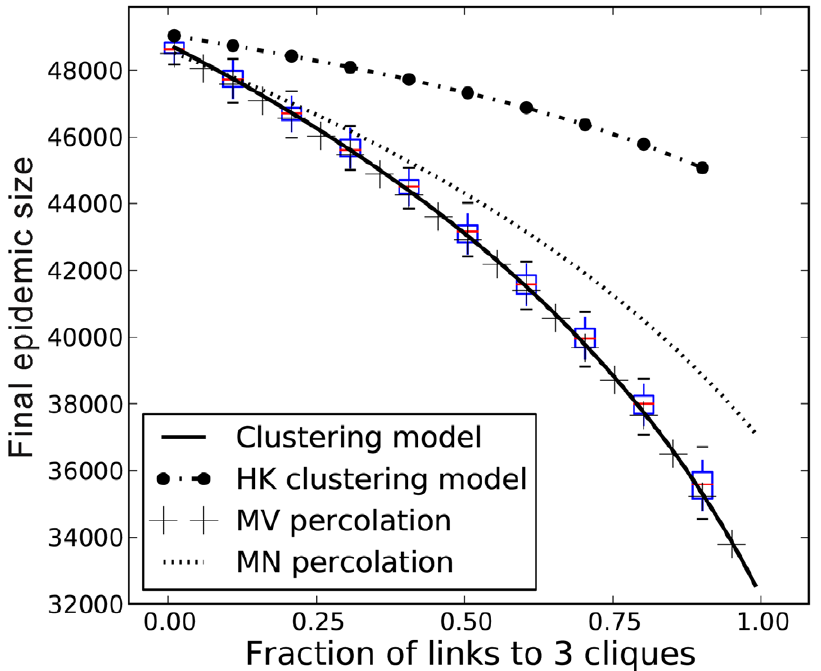
Figure 3. Comparison of clustering models. The degree distribution is Poisson for the number of pairs of edges (mean degree ~ 2 ). The black line corresponds to the solution of equations 13–17. The boxplots illustrate the 90% confidence interval from 50 stochastic simulations on networks with 5000 nodes. The remaining trajectories correspond to to the original bond percolation calculations [12,13], our modified bond percolation calculations, and the HK clustering model [19], respectively. b ~ 1 : 5, c ~ 1 .